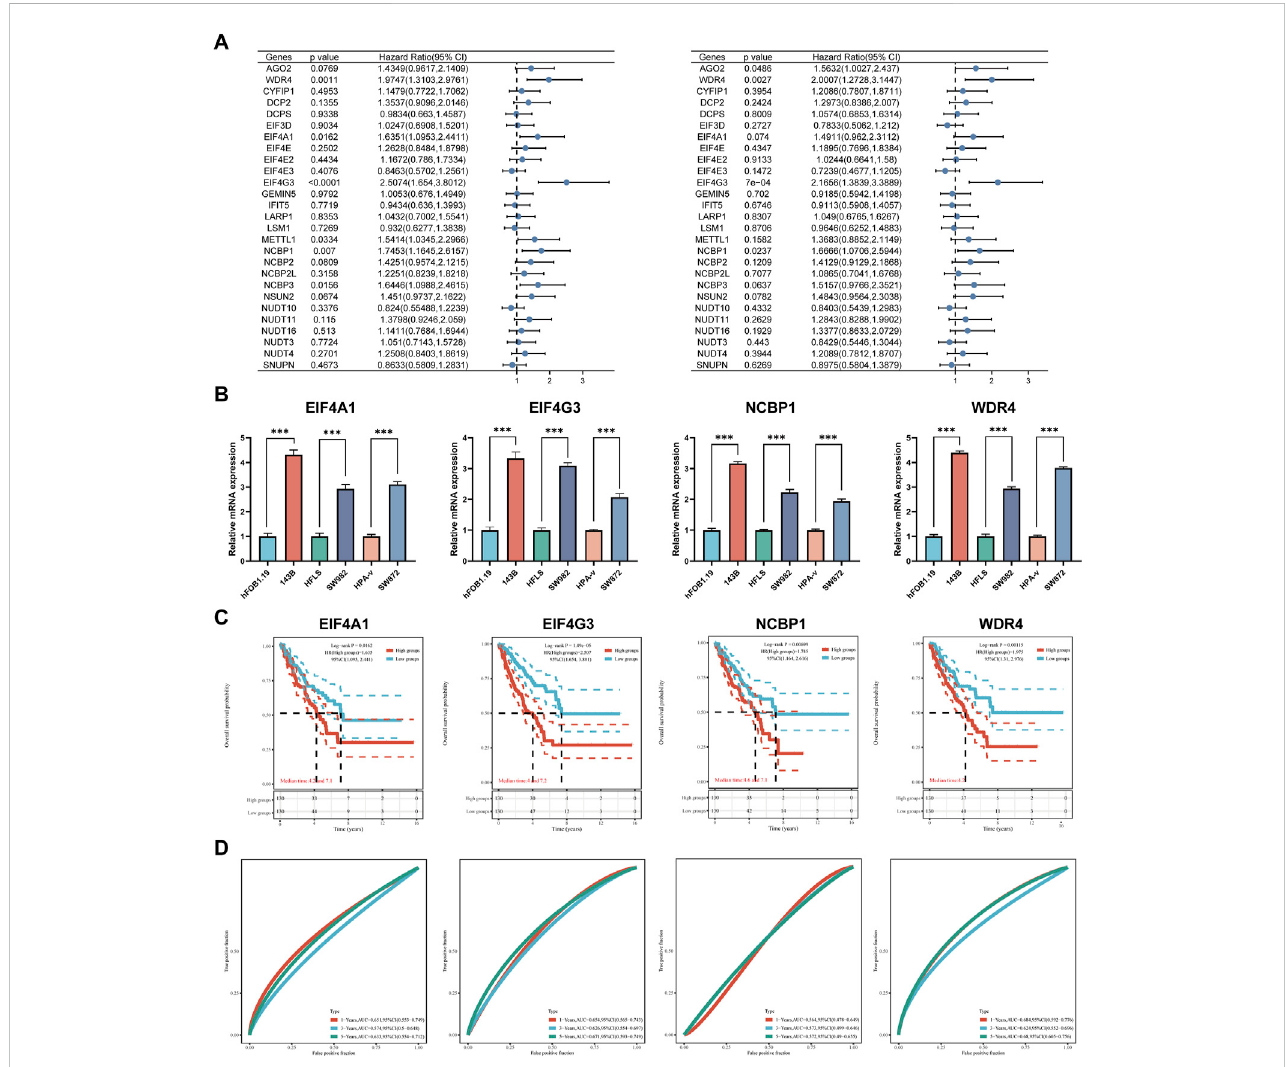
FIGURE 6 DEGs and prognostic models. (A) Analysis of four prognostic m7GRGs from univariate Cox regression analysis plots; (B) mRNA expression of prognostic m7GRGs in sarcoma cell lines and the corresponding normal cell lines; (C, D) Prognostic value of four m7GRGs (EIF4A1, EIF4G3, NCBP1, and WDR4) in sarcoma patients (OS curve of high/low expression